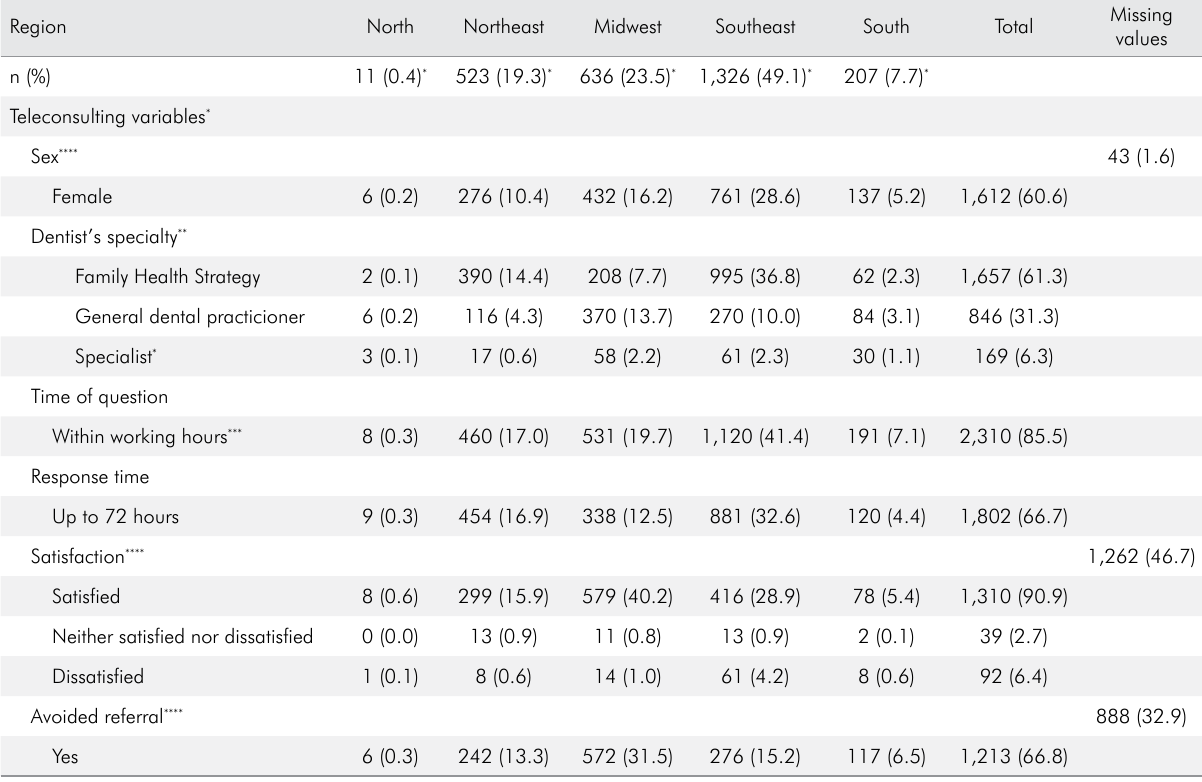
Table 2. Descriptive analyses of the profile of dental teleconsulting by region. Brazil, 2019. Region North Northeast